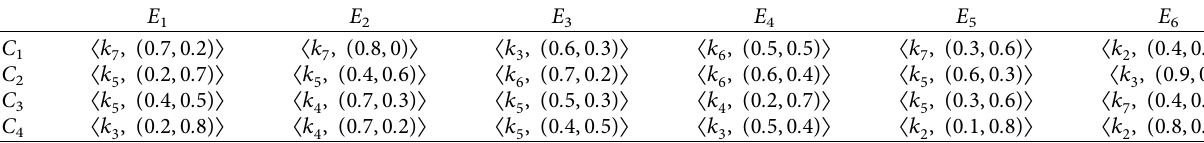
Table 4: Intuitionistic linguistic matrix-expert 2.